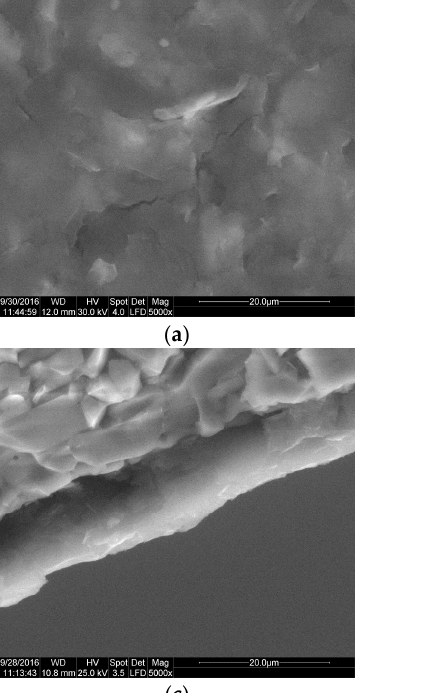
Figure 3. Frontal ( a , b ) and transversal ( c , d ) SEM images of the unmodified ( a , c ) and modified ( b , d ) SPCE.